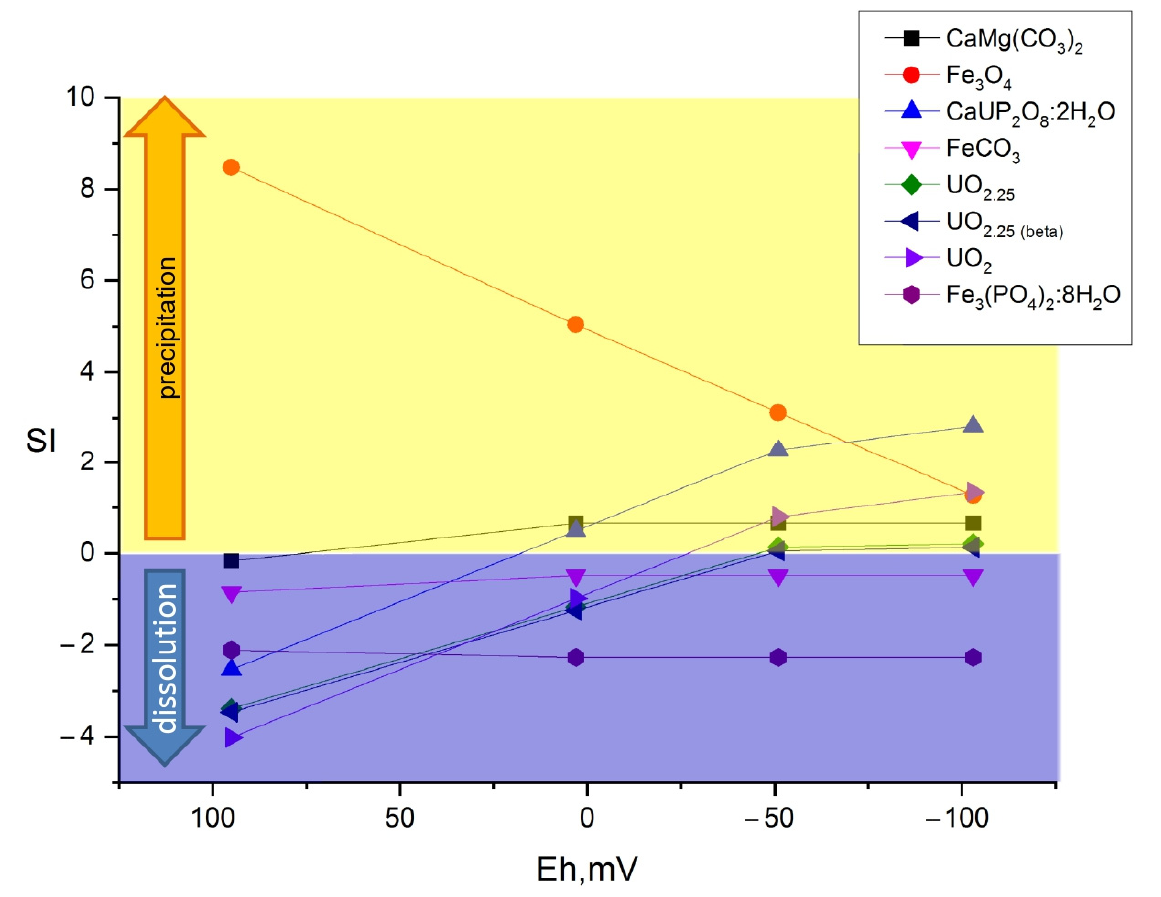
Figure 9. Distribution of main mineral phases before and after microbial processes in the sulfate and Ammophos sample.